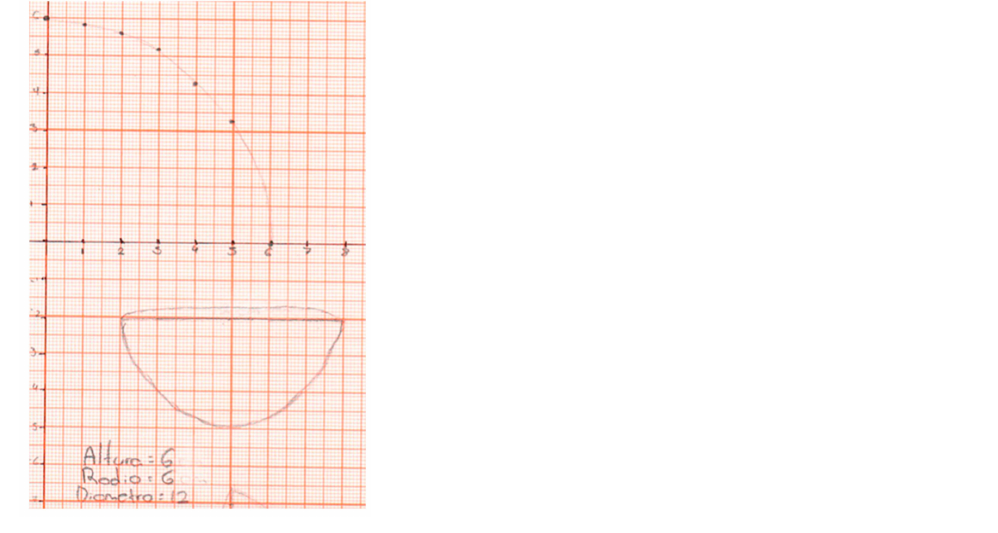
Figure 5. Student production: graph of the function representing a quarter of a circle. Note: At the bottom of the figure, we read height = 6, which corresponds to the cut with the ordinate axis, radius = 6 and diameter = 12, which we assume was used to draw the solid of revolution shown between the graph of the function and the